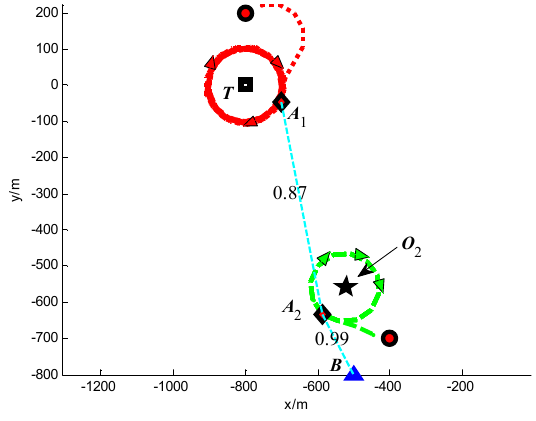
Figure 19. Trajectories of UAVs at t = 100 s (Group A in Scenario 2). Appl. Sci. 2018 , 8 , x FOR PEER REVIEW